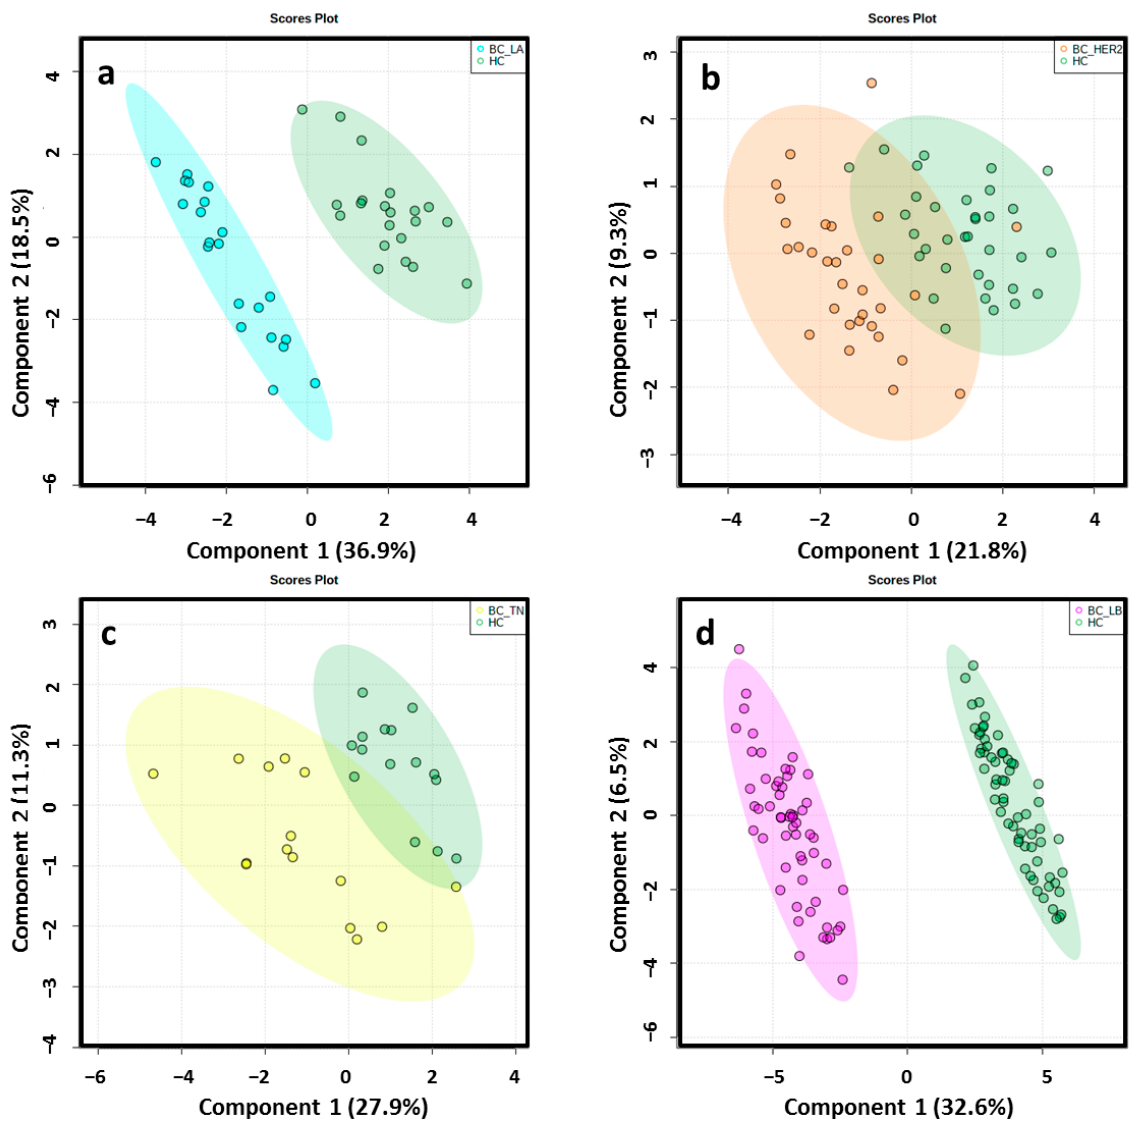
Figure 3. 2D score plots of the supervised PLS-DA of HC group (green) and LA_BC (light blue) ( a ), HER2_BC (orange) ( b ), TN_BC (yellow) ( c ) and LB_BC (pink) ( d ) patients by ESI − determined a notably separation between BC molecular subtypes and matched controls.